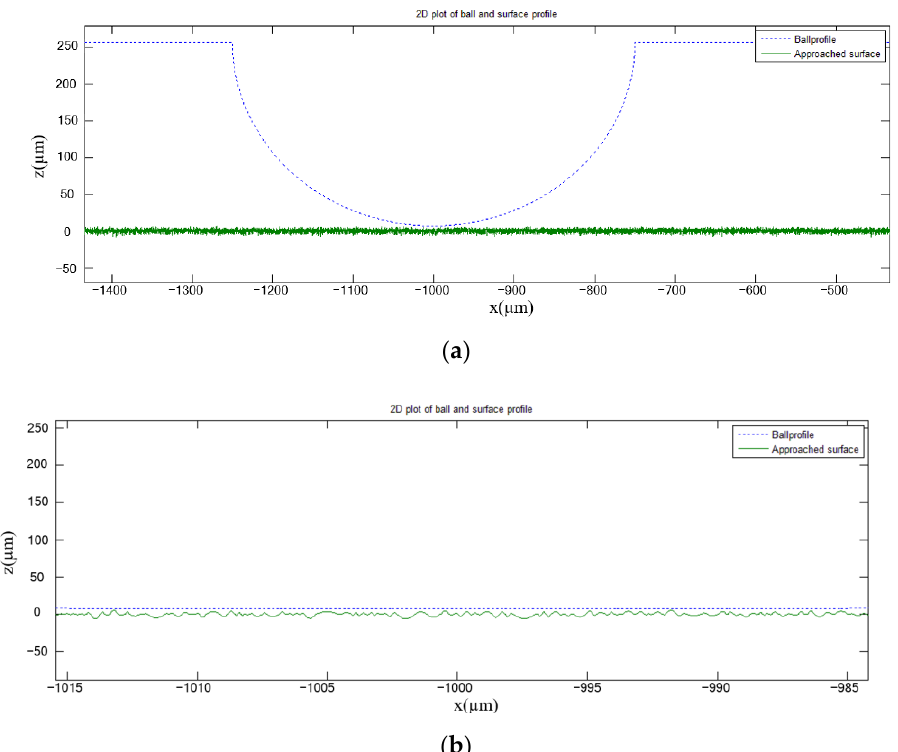
Figure 6. Visualization of two-dimensional contact between the ball and workpiece surfaces: ( a ) 1000 µ m length, and ( b ) in detail.